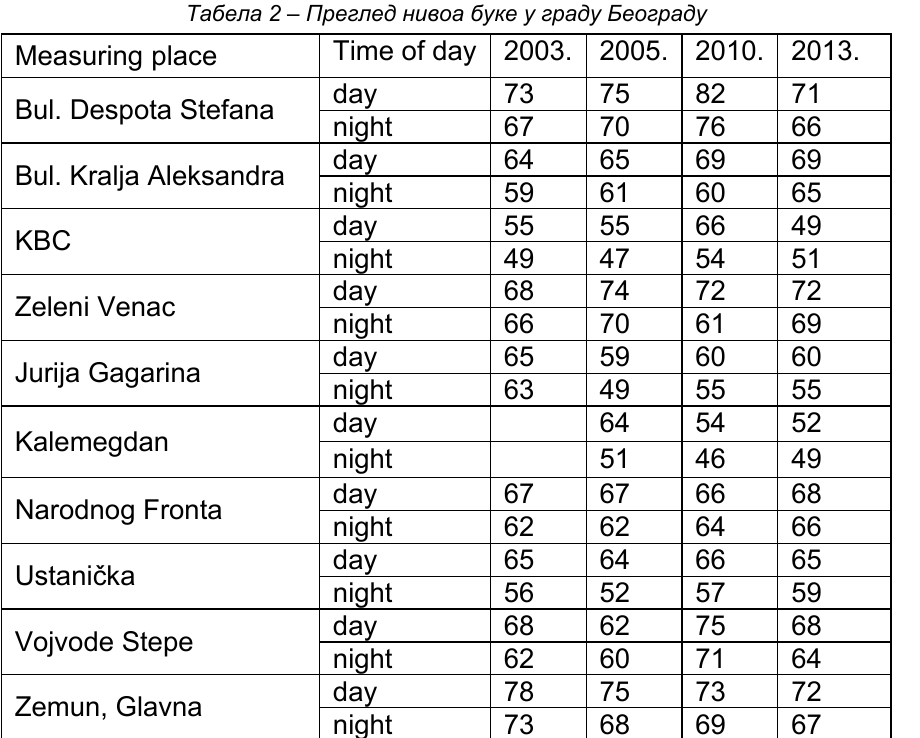
Table 2 – Overview of the noise level in the city of Belgrade Таблица 2 – Обзор уровня шума в городе Белград Табела 2 – Преглед нивоа буке у граду